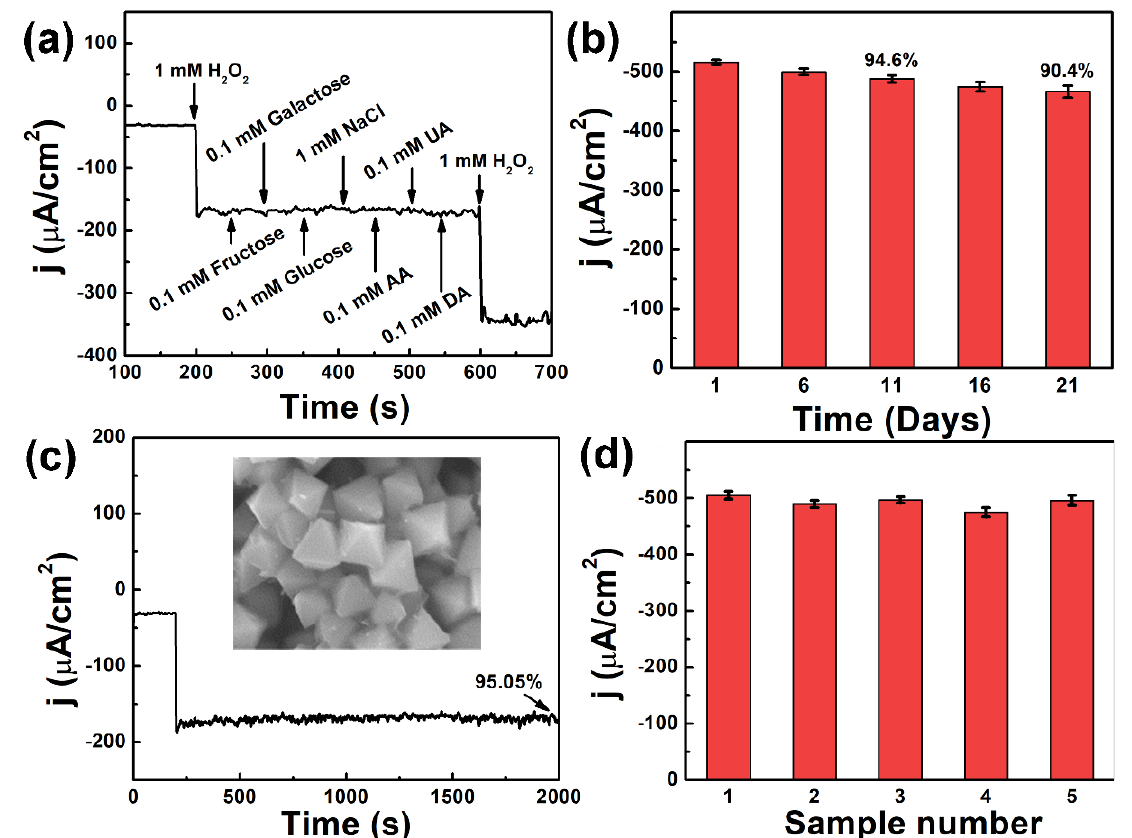
Figure 6. ( a ) Amperometric response of R-CeO 2 -O upon the successive addition of 1 mM H 2 O 2 , 0.1 mM fructose, 0.1 mM galactose, 0.1 mM glucose, 1 mM NaCl, 0.1 mM AA, 0.1 mM UA, 0.1 mM DA, and 1 mM H 2 O 2 in 0.1 M PBS at a bias voltage of −0 .5 V. ( b ) The current density response toward 1 mM H 2 O 2 after different durations. ( c ) Response current density of R-CeO 2 -O during 2000 s upon addition of 1 mM H 2 O 2 . The inset in ( c ) shows the SEM image of R-CeO 2 -O after sensing. ( d ) Current density of five electrodes in response to 1 mM H 2 O 2 . Table 2. Analytical results for the determination of H 2 O 2 in medical disinfectant